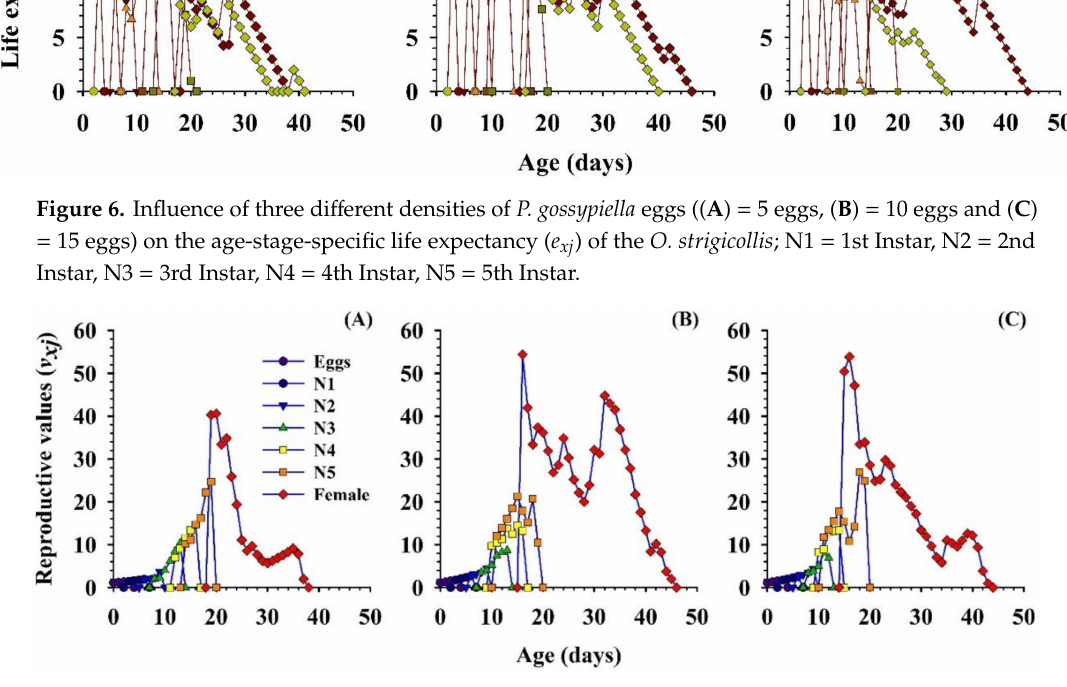
Figure 7. Influence of three di ff erent densities of P. gossypiella eggs (( A ) = 5 eggs, ( B ) = 10 eggs and ( C ) = 15 eggs) on the age-stage reproductive value ( v xj ) of the O. strigicollis ; N1 = 1st Instar, N2 = 2nd Instar, N3 = 3rd Instar, N4 = 4th Instar, N5 = 5th